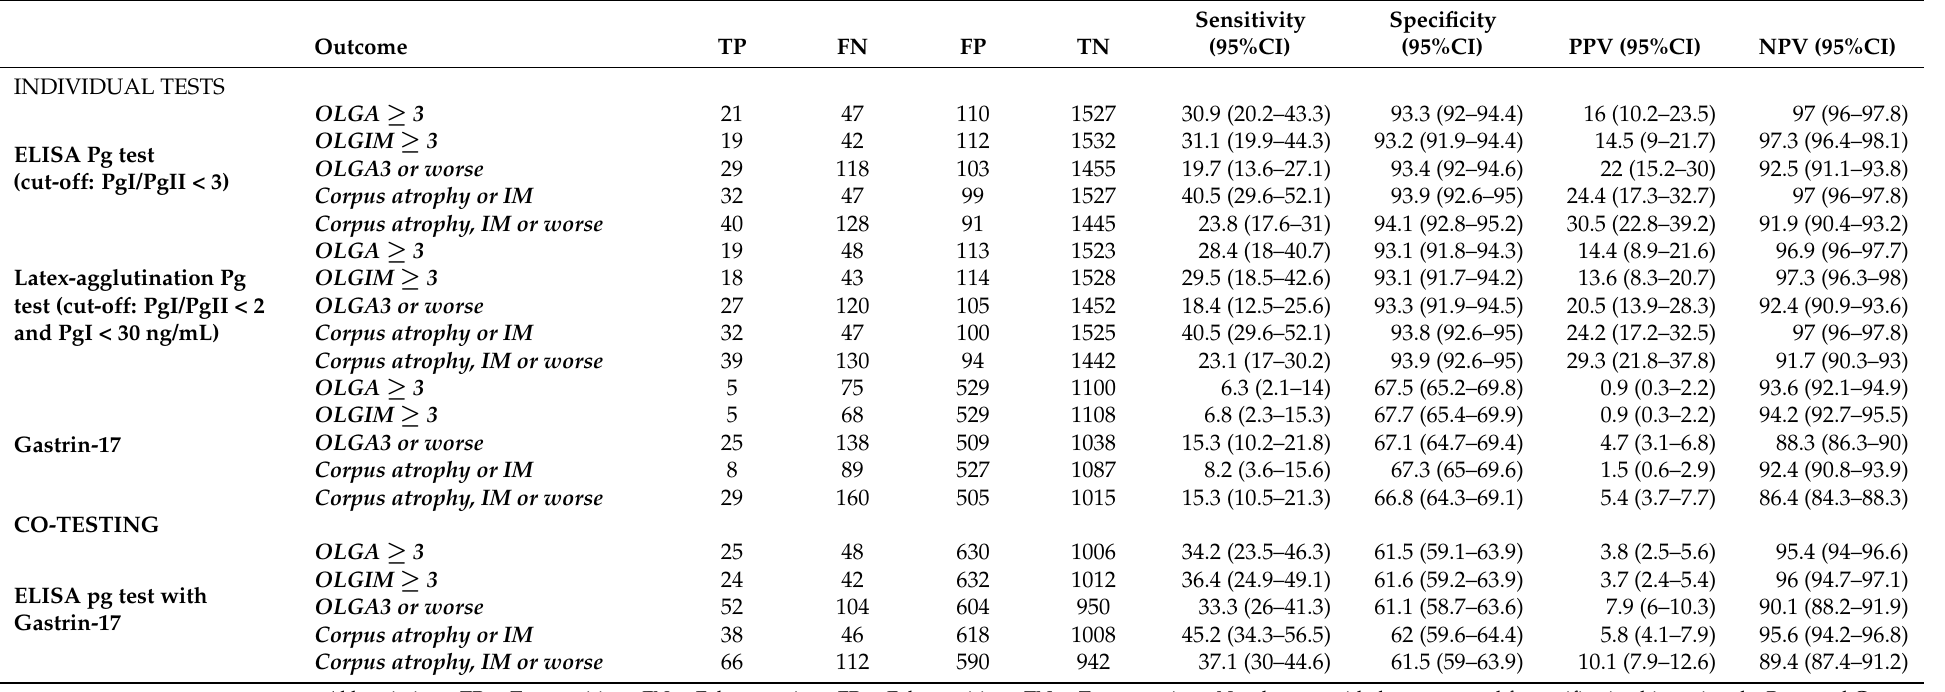
Table 2. Performance of pepsinogen and gastrin-17 tests, individually and co-testing, to detect study